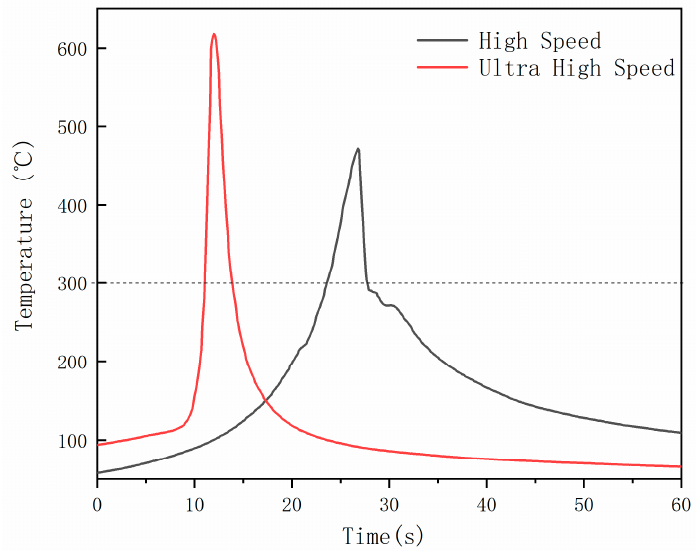
Figure 10. Thermal history of the aluminum alloy retracted side under HRS and ultra-HRS low tool offset parameters.